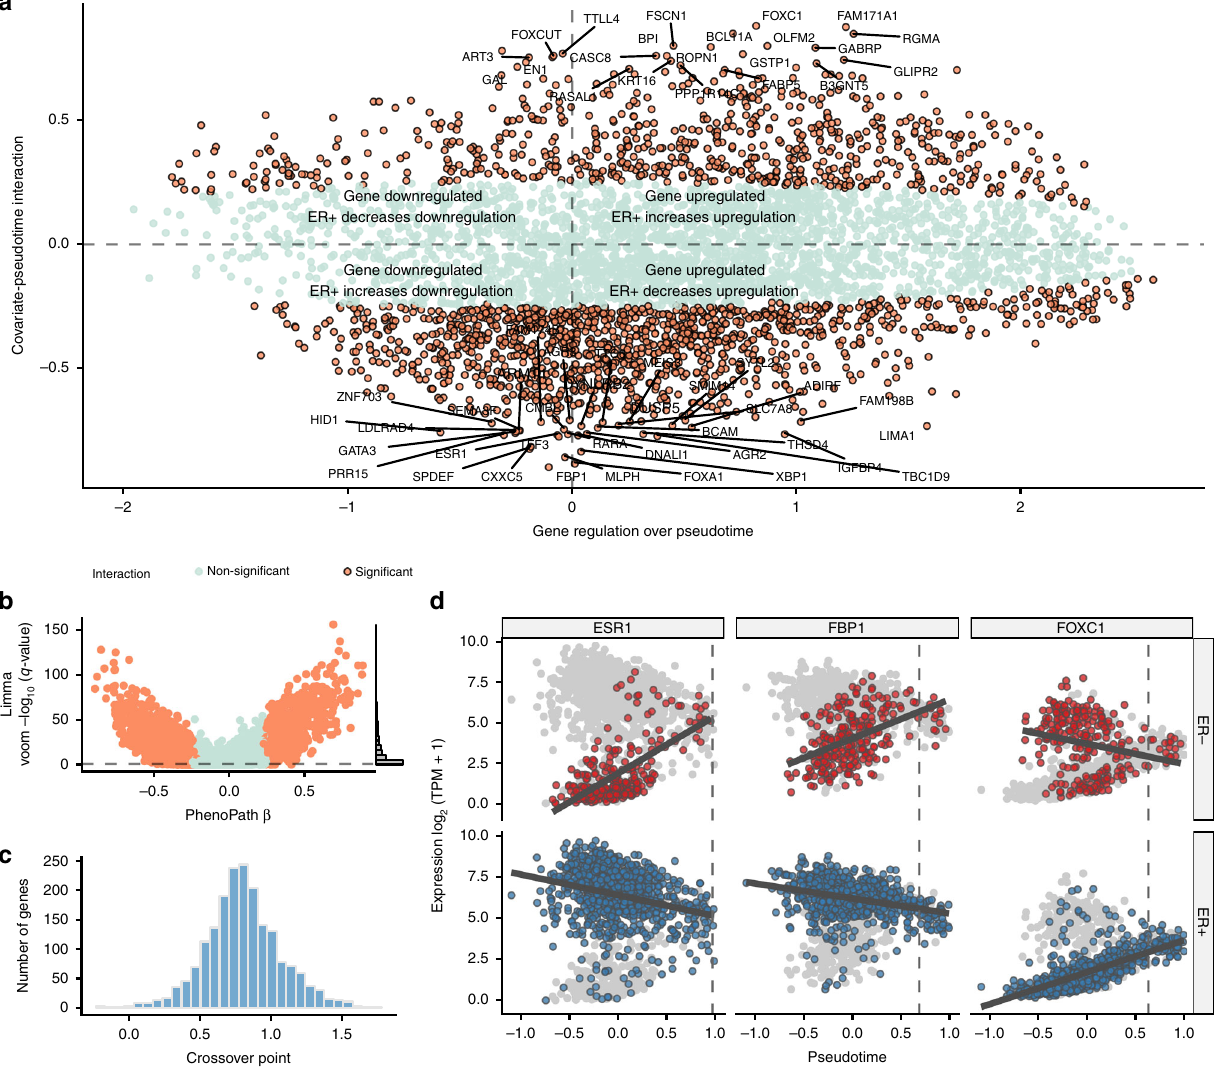
Fig. 7 Vascular growth-ER status interactions uncovered by PhenoPath in breast cancer. a PhenoPath applied to Breast Cancer (BRCA) RNA-seq expression data uncovers a landscape of interactions between the inferred angiogenesis trajectory and estrogen receptor (ER) status. b A comparison to the FDR-corrected q -values reported by Limma Voom identi fi es a signi fi cant number of DE genes display an interaction with ER status and the anthropogenic pathway. c A histogram of the cross-over points of all genes whose trajectory-covariate interactions were signi fi cant. The vast majority of cross-over points are at the end of the trajectory (around 0.8, where the “ middle ” pathway score is 0) implying a convergence of gene expression as the trajectory progresses. d Three example genes ESR1 , FBP1 , and ( FOXC1 ) were identi fi ed by PhenoPath as signi fi cantly perturbed along the angiogenesis trajectory by ER status. The vertical dashed line signi fi es the calculated cross-over point, demonstrating the expression pro fi les of these genes converge towards the end of the